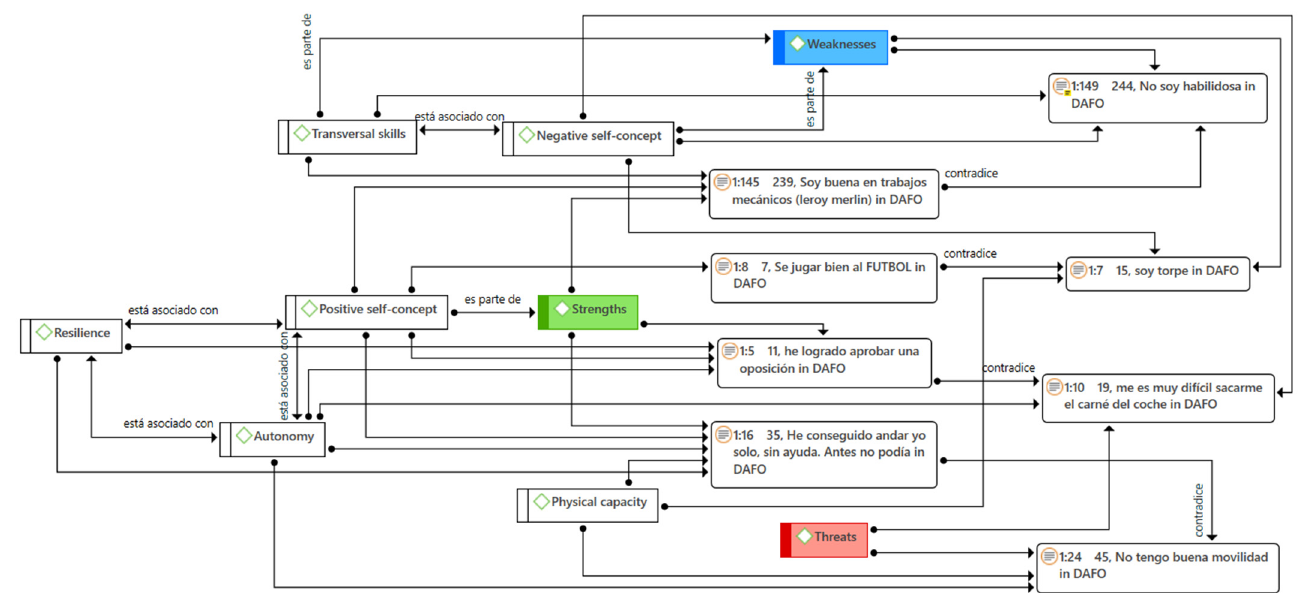
Figure 6. Semantic network of contradictions in SWOT perception.